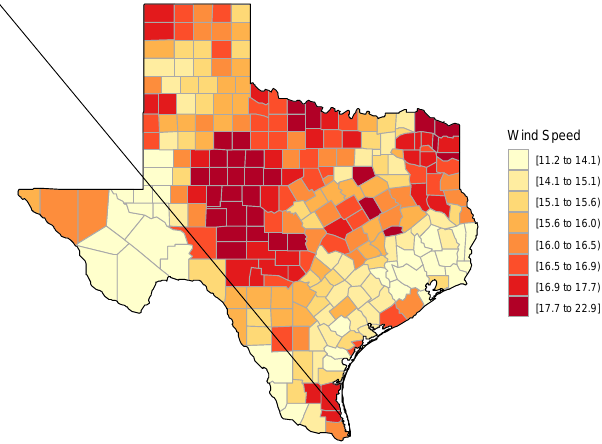
Figure 1. Choropleth map of wind speed by county in Texas.